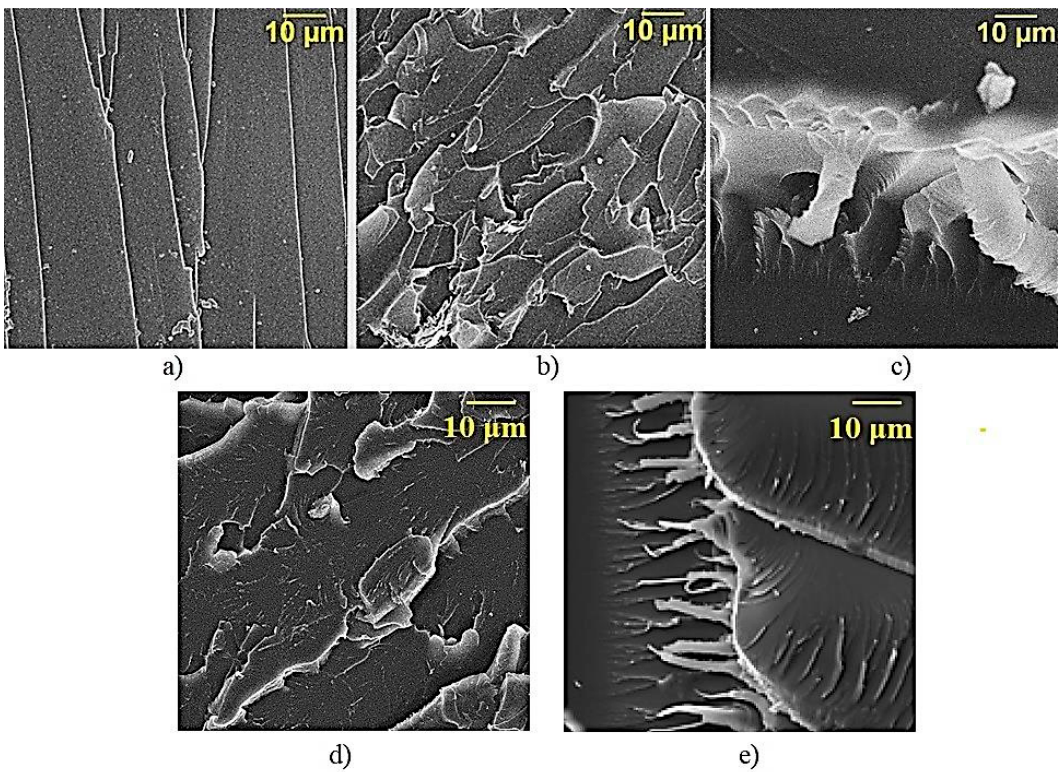
Figure 9. SEM of the surface of epoxy composites destruction: ( a ) unfilled composite; ( b , c ) composite filed with 0.1 parts by mass pristine MWCNTs; ( d , e ) composite filled with 0.1 parts by mass APTES-treated MWCNTs.